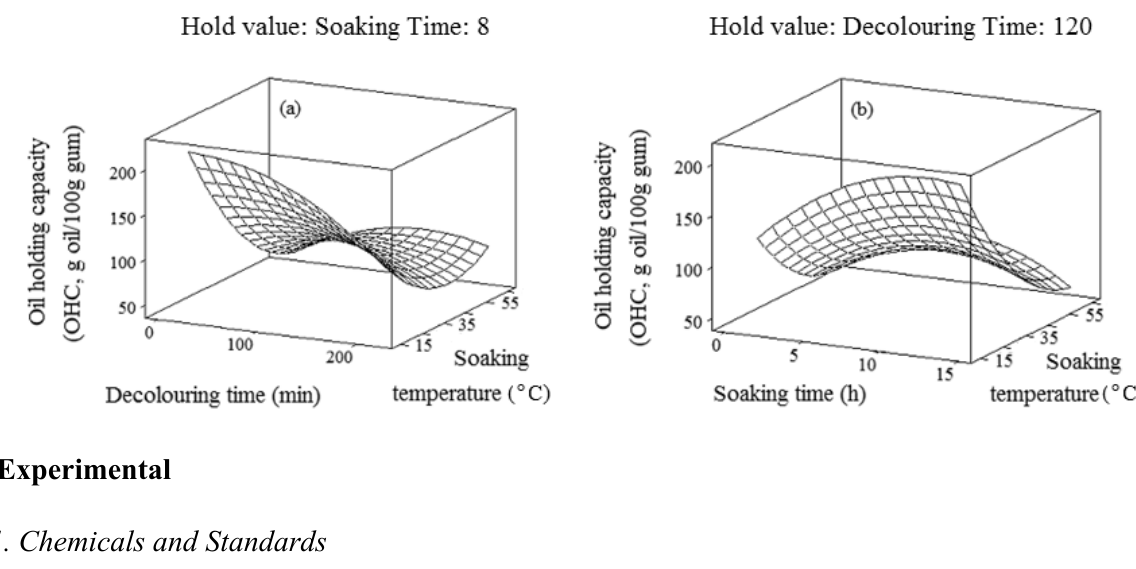
Figure 5. Response surface plots for explaining the variation of oil-holding capacity (OHC) as a function of ( a ) decolouring time and soaking temperature and ( b ) soaking time and